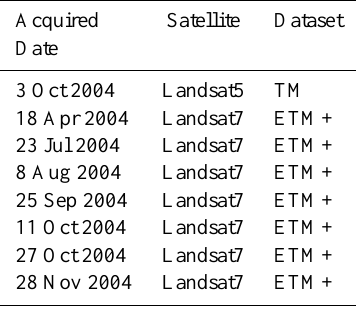
∗ The scene path and row are 122 and 041,